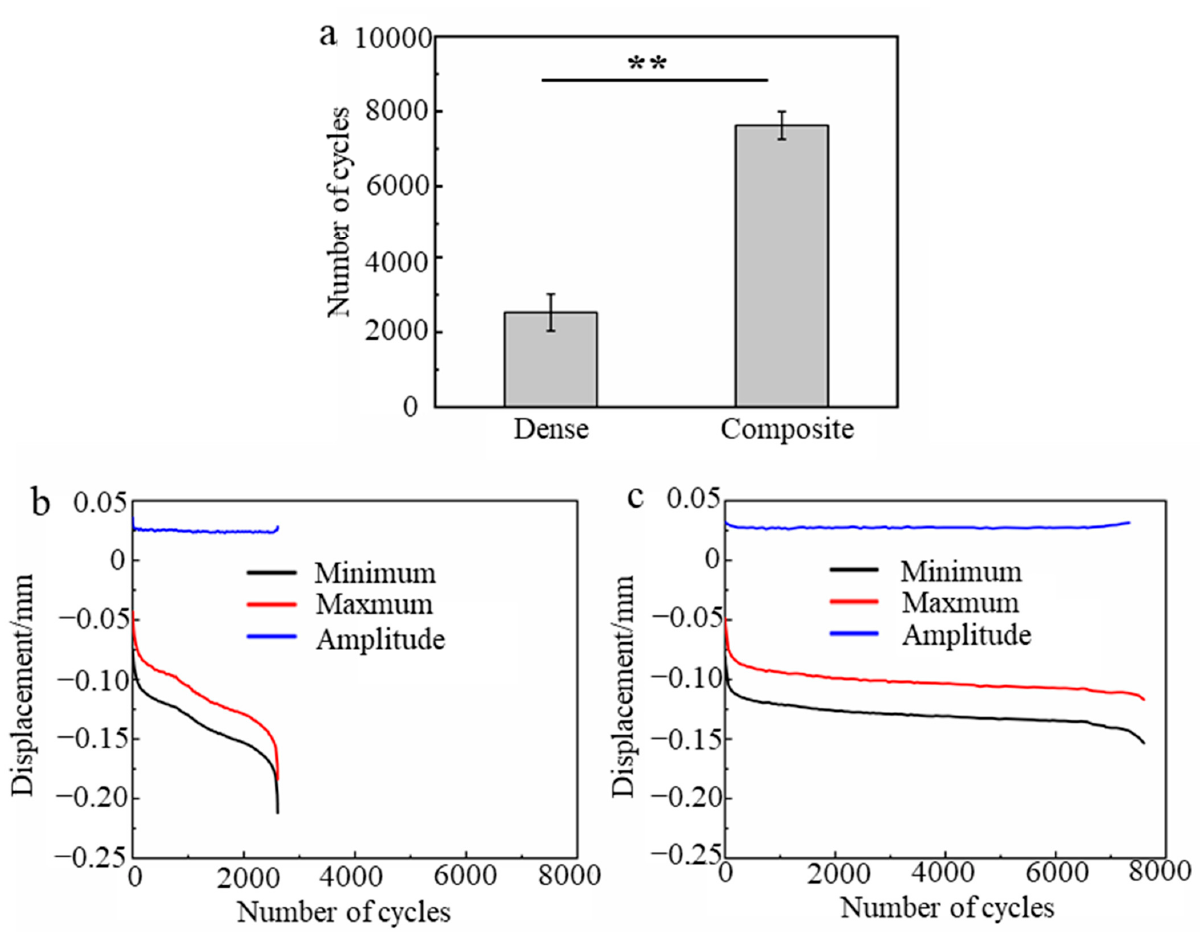
Figure 10. Compressive fatigue performances of the dense and composite scaffolds. ( a ) Number of cycles for dense and composite scaffolds, representative evolutions of the minimum, maximum and amplitude of the displacement: ( b ) dense scaffolds ( c ) composite scaffolds. (Data presented are the mean ± standard error of the mean, n = 3, ** p < 0.01).